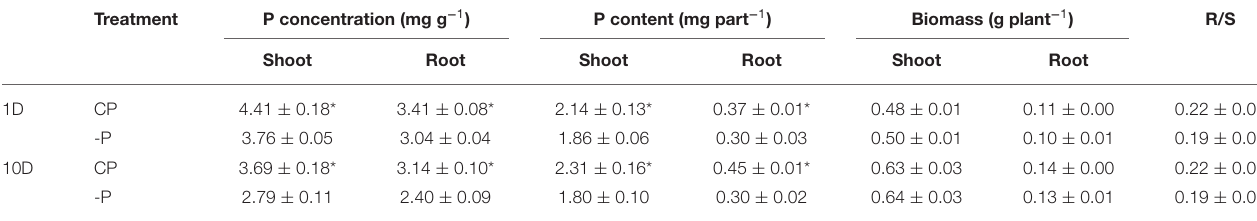
TABLE 1 | Effects of Pi deficiencies on P concentration, P content, biomass, and Root/Shoot ratio (R/S) in Zygophyllum xanthoxylum . Treatment